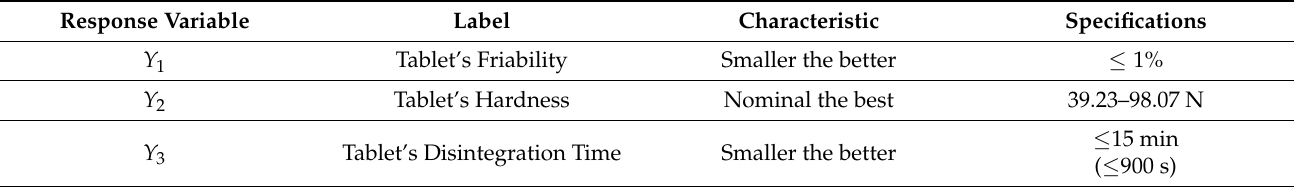
Table 1. Response Variables (Tablet’s Quality Characteristics).